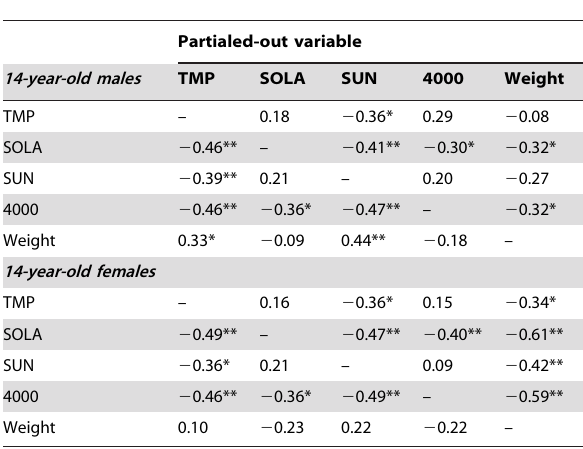
Table 7. Partial correlation coefficients of the relationship between weight and climatic variables on the basis of